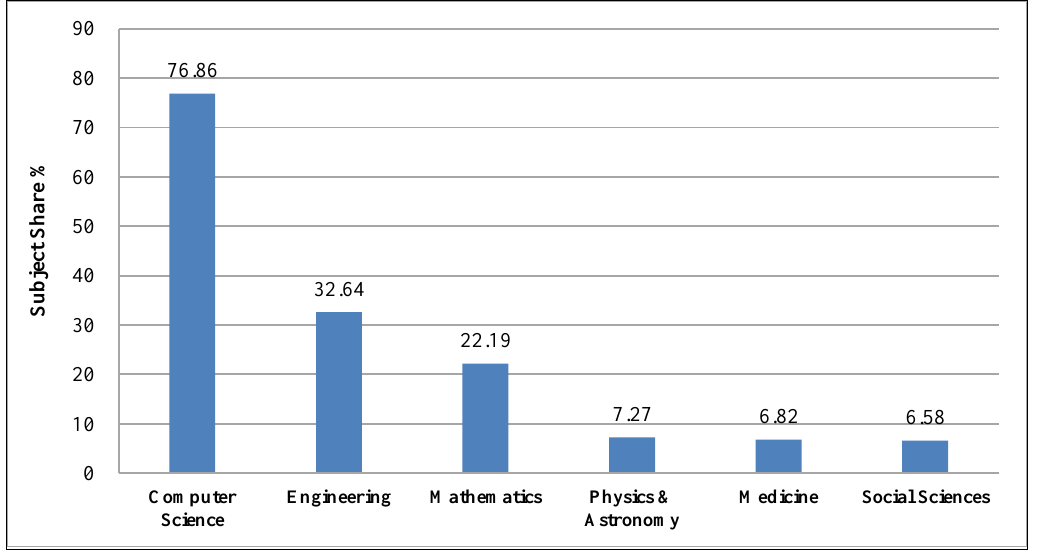
Figure 3. Deep Learning Research by Subject 2004-17